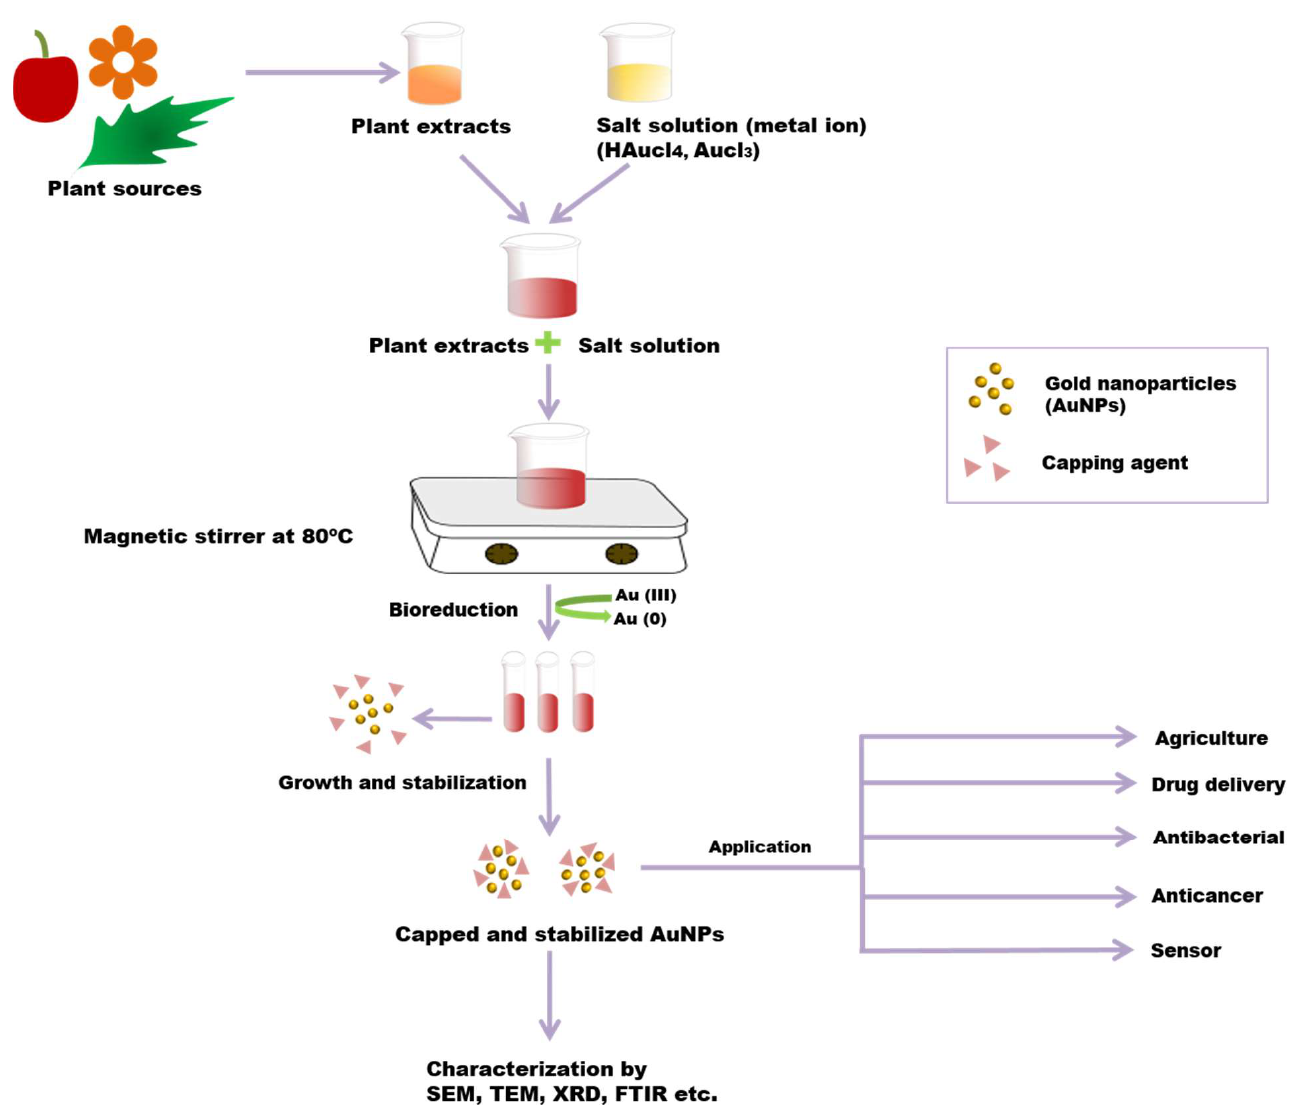
Figure 3. Green synthesis of AuNPs from a plant. Plant extract and metal salt solution HAuCl 4 were mixed. After that, the resultant solution is centrifuged, which results in the bio reduction of metallic ions to AuNPs. Phytochemicals act as reducing, as well as stabilizing/capping, agents in this process. The resultant AuNPs are characterized by using SEM, TEM, FTIR, XRD, etc.